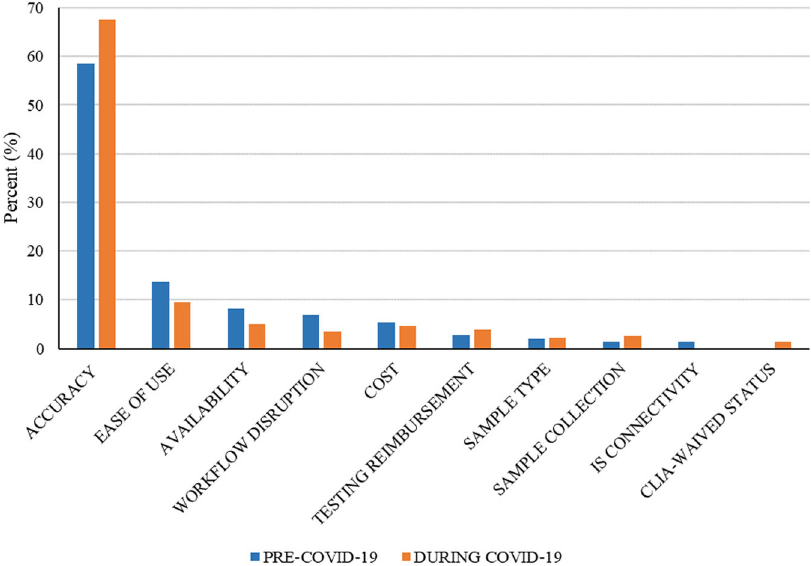
Fig. 5 During COVID-19, the accuracy and CLIA-waived status categories experienced the greatest percentage increase among characteristics that healthcare professionals considered important for POCTs.